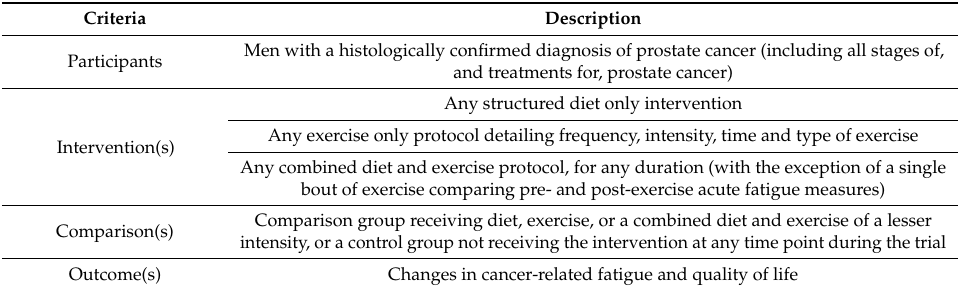
Table 1. Description of the Population, Intervention, Control, Outcome (PICO)